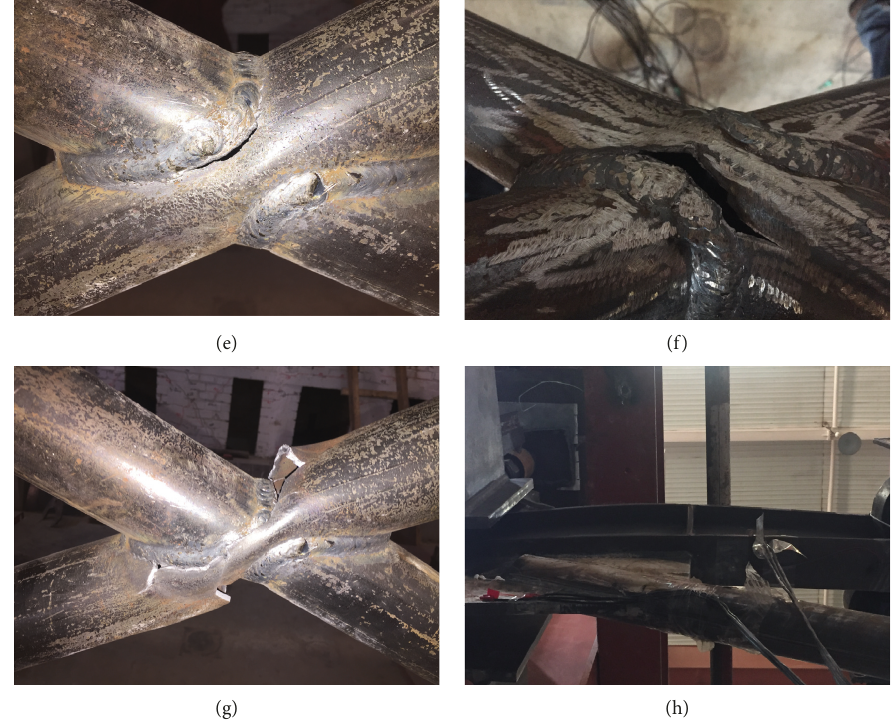
Figure 6: Failure phenomenon of the specimen C-JB. (a) Deformation of the connection. (b) Crack of the connection of the floor-two brace. (c) Crack of the brace expanded. (d) Floor-two brace broke. (e) Crack of the connection at the floor-one brace. (f) Serious damage of the brace. (g) Floor-one braces broke. (h) Out of plane buckling of the floor-two